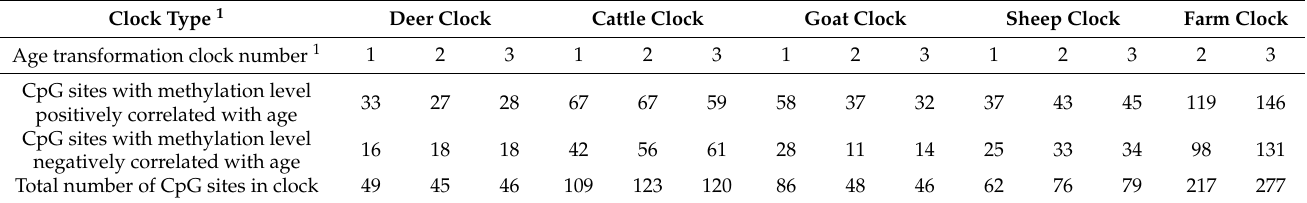
Table 2. Number of CpG sites selected by elastic net regression for the construction of each epigenetic clock.